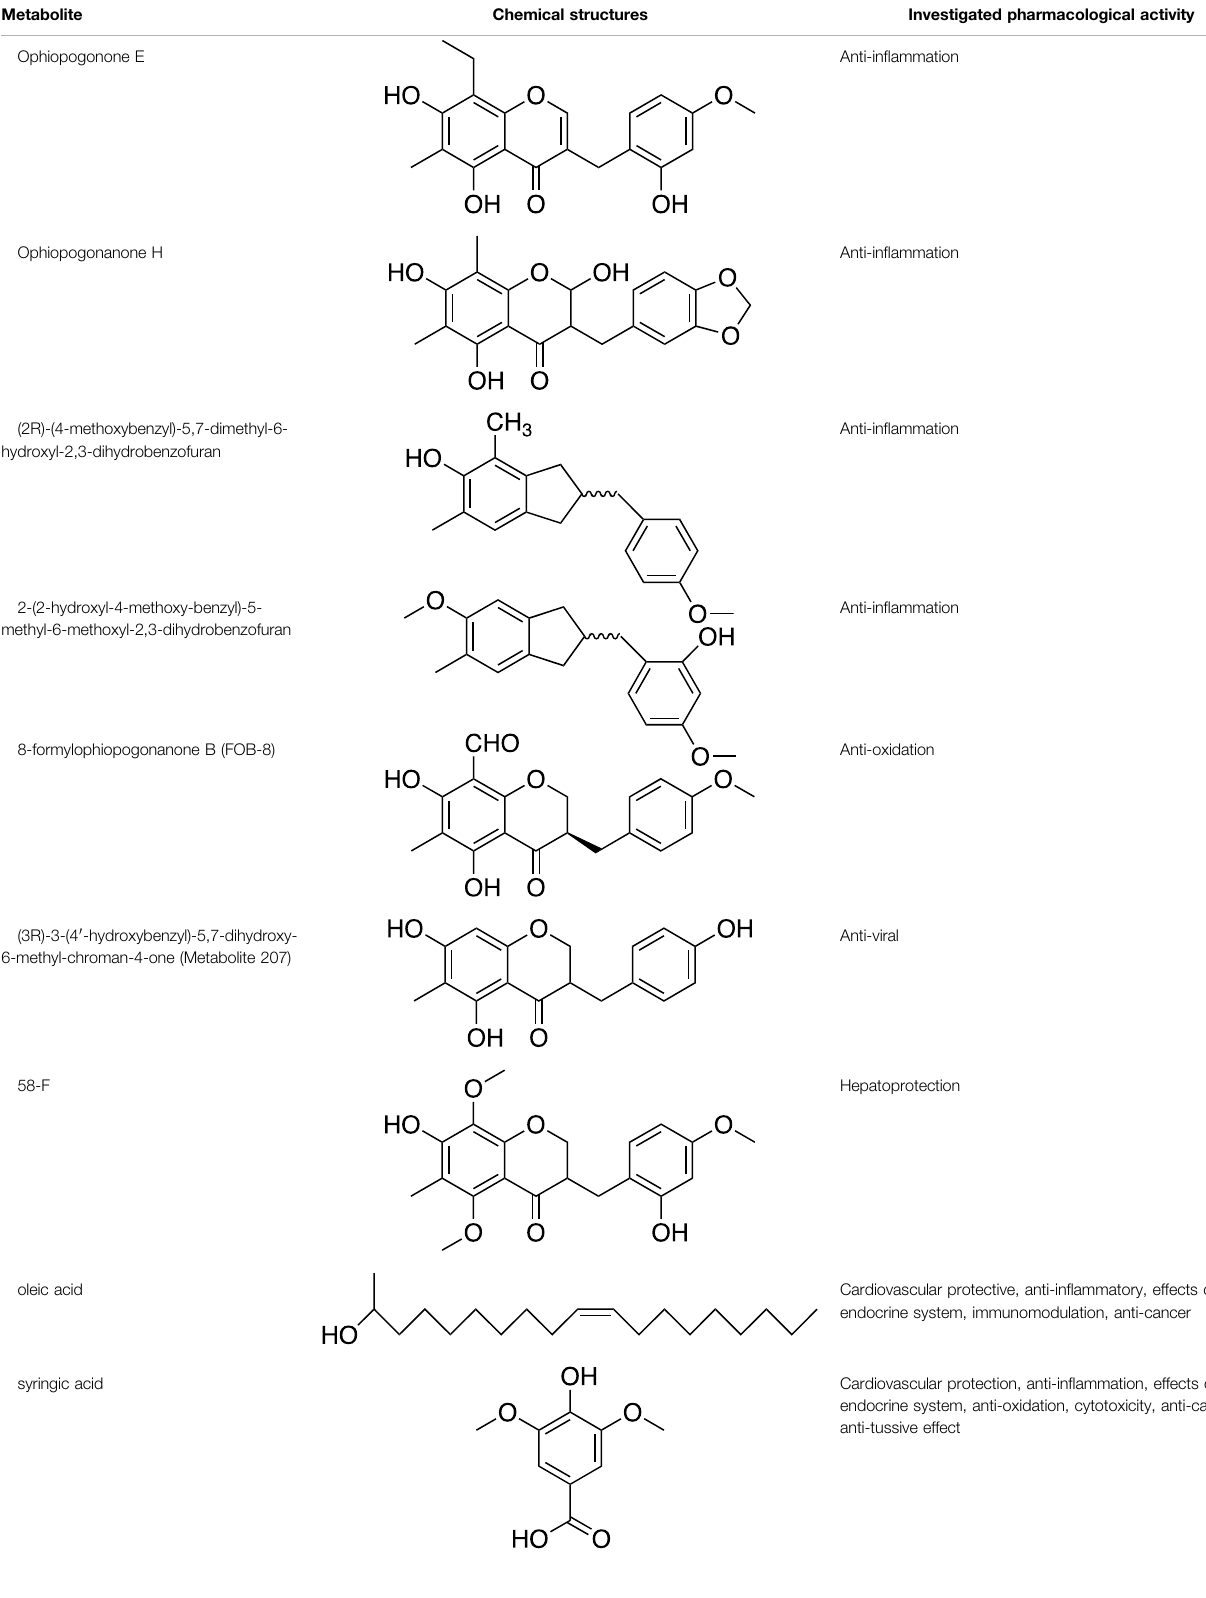
TABLE 2 | ( Continued ) Chemical structures of pharmacologically investigated metabolites with corresponding activities of liriopogons (details of activities can be found in Table